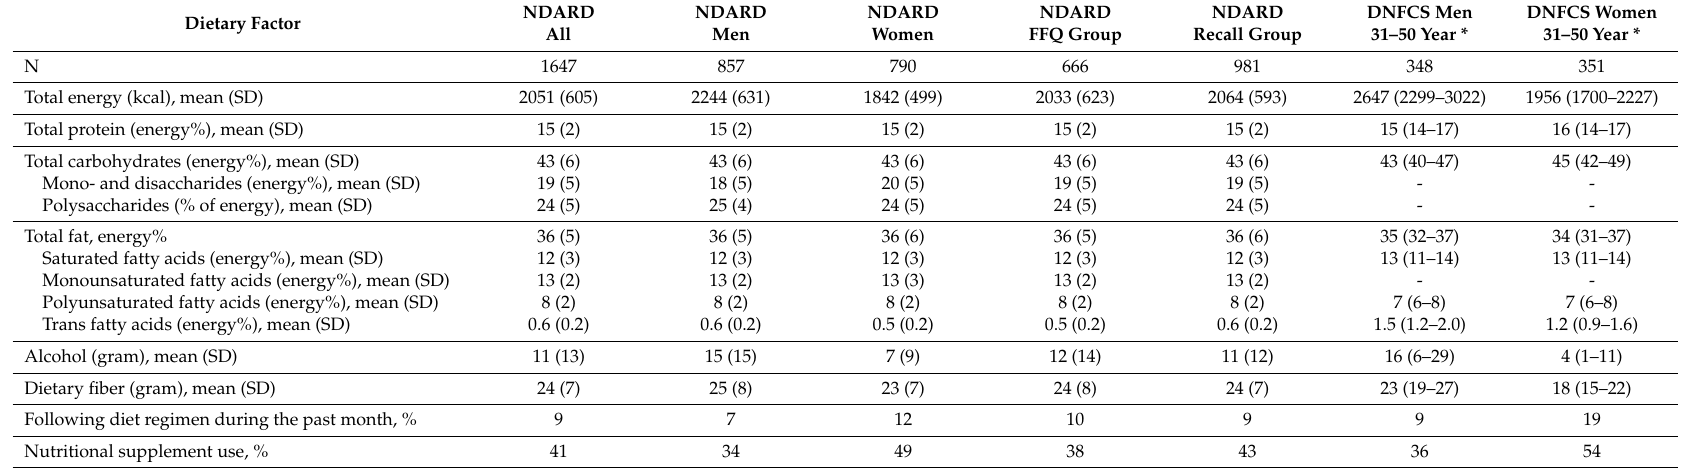
Table 4. Comparison of the dietary intake of the NDARD participants, as assessed with a general Food Frequency Questionnaires (FFQ), and the